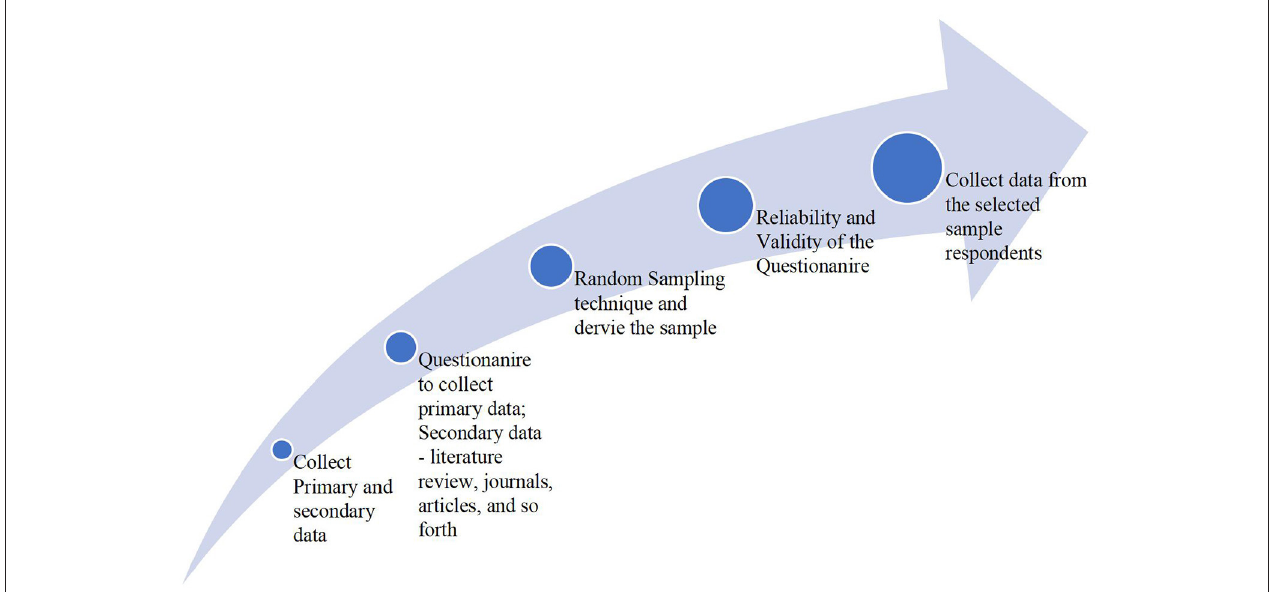
FIGURE 2 | Flow chart of the methodology.